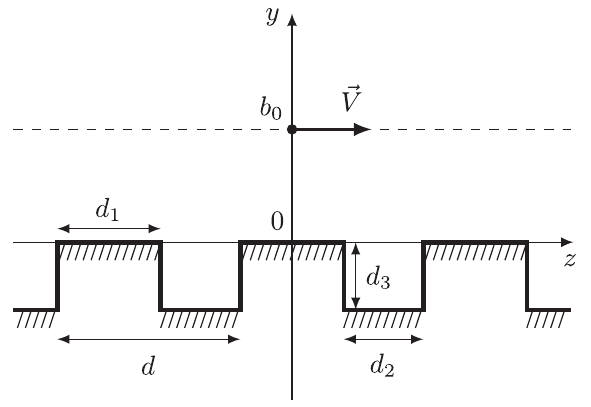
FIG. 1. The corrugated surface and moving